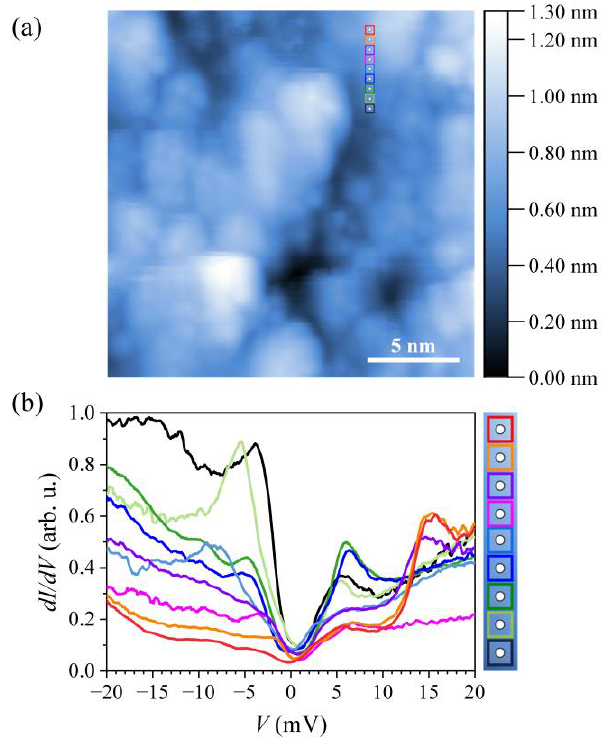
Figure 12. ( a ) A 15 × 15 nm 2 STM topographic image of the HTZS-Nb sample surface imaged at V = 400 mV and I = 100 pA. The nine dots separated by 0.5 nm (each enclosed by a square of different color) represent locations of the STS measurements. ( b ) dI / dV curves, where the color of each curve matches the color of the square enclosing the point of origin. Local maxima in the dI / dV curves are interpreted as localized states in the LDOS close to the Fermi energy.